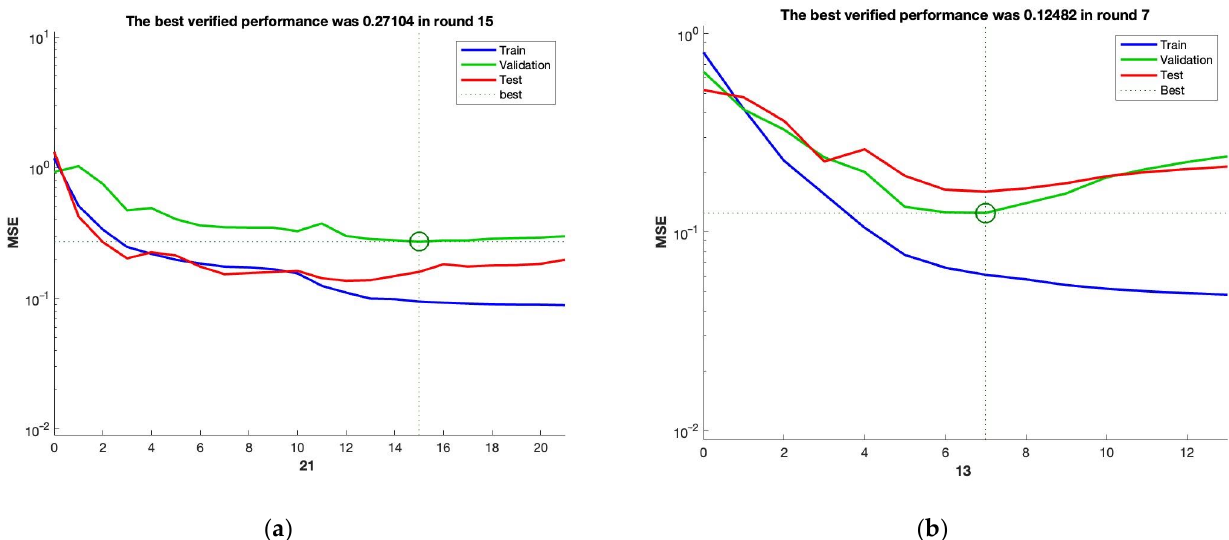
Figure 4. ( a ) is an iterative graph of the prediction of surface roughness by the BP model; ( b ) is an iterative graph of the prediction of the surface roughness by the CPA-BP model.